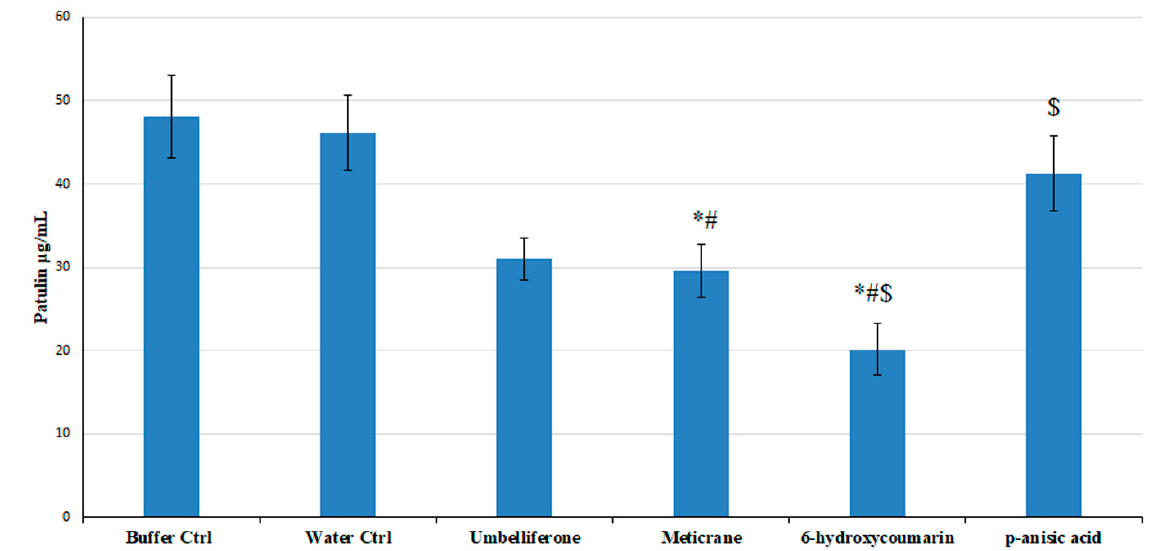
Figure 5. Patulin accumulation in Golden Delicious apples treated (100 µ g/wound) or untreated by the selected compounds. Reported data are means ± standard errors (SE) of at least three replicates. Statistically significant differences (Turkey test, p ≤ 0.05) are indicated by means of symbols “*,#, $” for analyses in presence of the newly proposed ligands, namely Meticrane, 6-hydroxycoumarin and p -anisic acid with respect to Buffer Ctrl (consisting of PBS + NaOH), Water Ctrl (consisting of H 2 O) , and the known inhibitor umbelliferone. The symbols “*,#, $” indicate a p ≤ 0.05 for each indicated treatment compared to Buffer control (*), Water control (#), or Umbelliferone treatment ($), respectively.